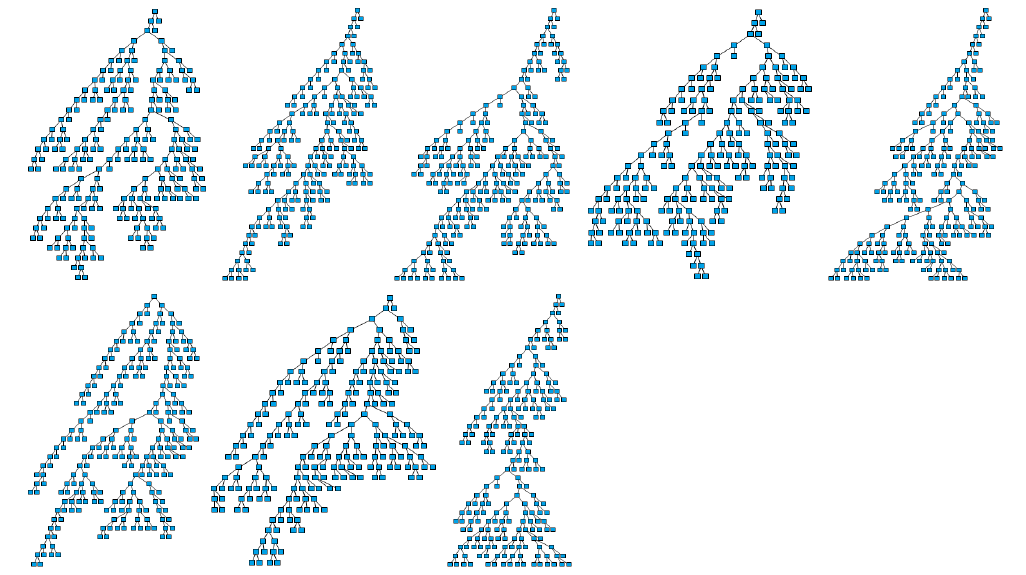
Figure 20. Training Decision Trees generated by the Multiclass Decision Forest